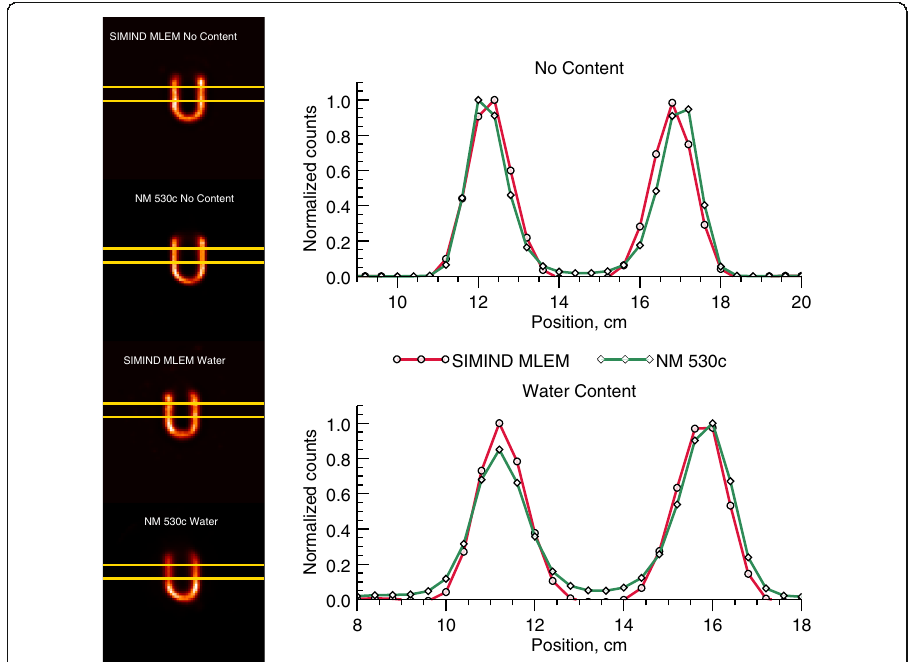
Fig. 10 Comparison of line profiles over the myocardium in empty (top) and water-filled (bottom) torsos for MCR and NM 530c reconstruction (40 iterations). The summed profile was calculated from the seven rows in between the yellow markings. A zoomed-in section of the profile is shown in each case to highlight the differences between the two profiles, and each symbol represents a voxel value. The MCR images were filtered post-reconstruction with a Butterworth low-pass filter (cut-off: 0.5 cm − 1 , order: